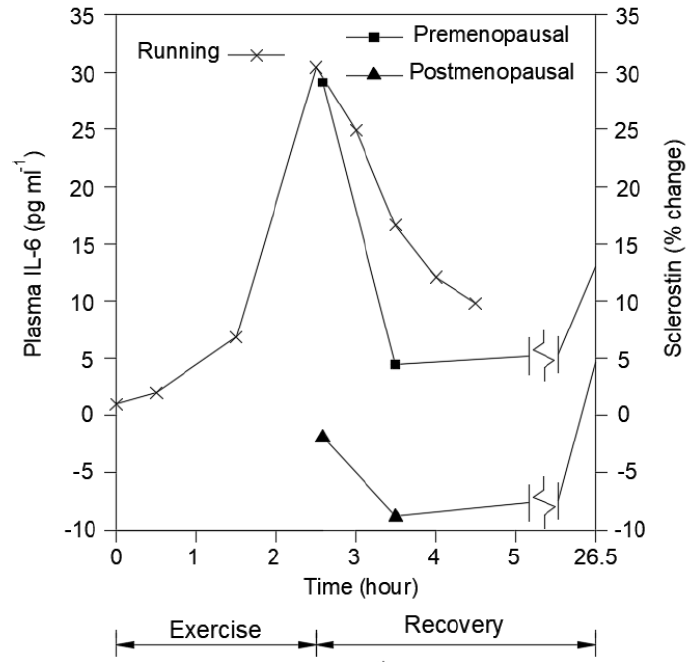
Figure 2. Data for the cytokine IL-6 as reported in Steensberg et al. [26] are plotted (Running data); the data were obtained from seven male endurance trained runners aged 24–50 years who ran on a treadmill at 75% VO2 max for 2.5 h, having reported to the lab at 0800. The sclerostin (osteokine) data (solid squares and diamonds) are—as reported in Nelson et al. [27]—acquired from 20 pre-menopausal and 20 post-menopausal women who arrived at the lab between 0800 and 0900, were provided a specified breakfast and then did a series of jumping exercises before blood samples were taken. Baseline data for these latter two groups are zero on that scale.